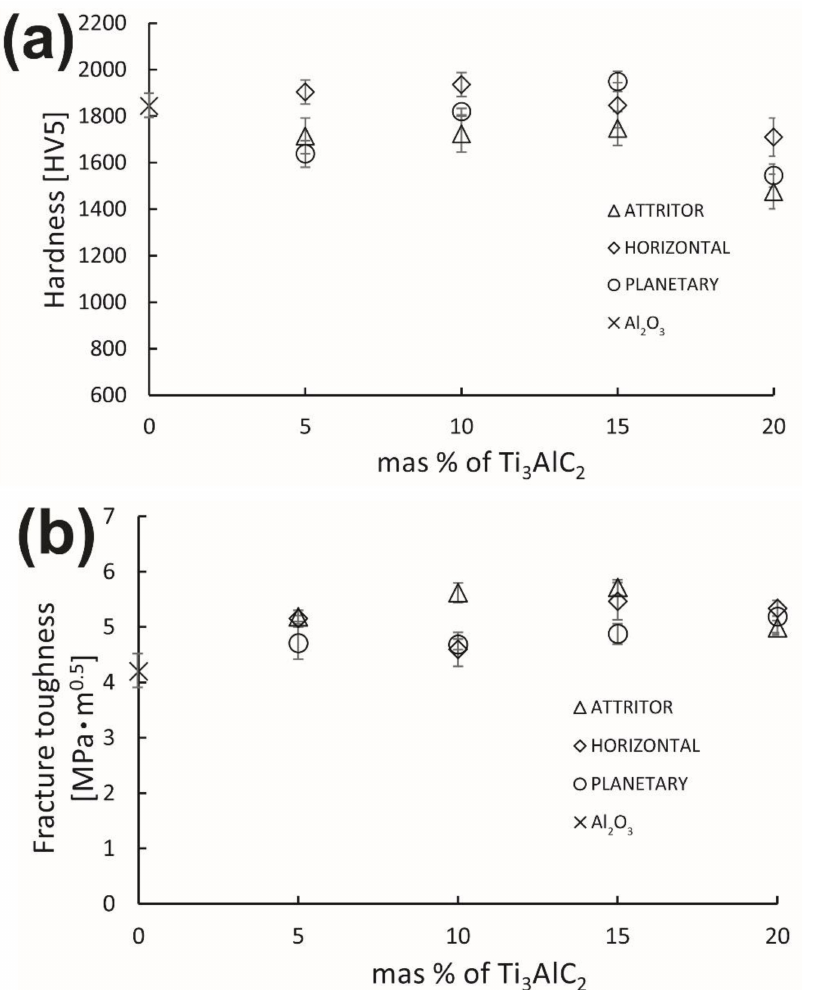
Figure 11. ( a ) Hardness of Al 2 O 3 -Ti 3 AlC 2 composites; ( b ) fracture toughness of Al 2 O 3 -Ti 3 AlC 2